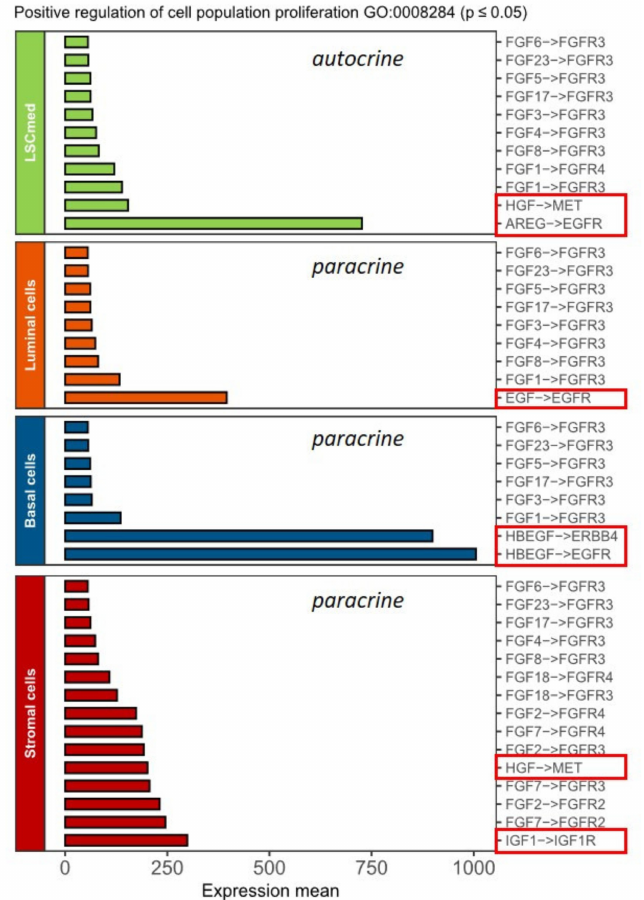
Figure 4. In silico prediction of growth factors regulating LSC med cell proliferation. Bar di- agram representing the significant ligand–receptor interactions identified by CellPhoneDB analysis applied to transcriptomic data of epithelial (LSC med , luminal, basal) and stro- mal cells of WT mouse prostate [5]. Only interactions involving receptors expressed by LSC med cells and secreted ligands expressed by any of the four prostate cell compartments are reported. Red boxes identify interactions that have been experimentally challenged in this study (Ligand → Receptor). Expression Mean = mean ( mean ( Receptor , compartment X ) , mean ( Ligand , compartment Y ))